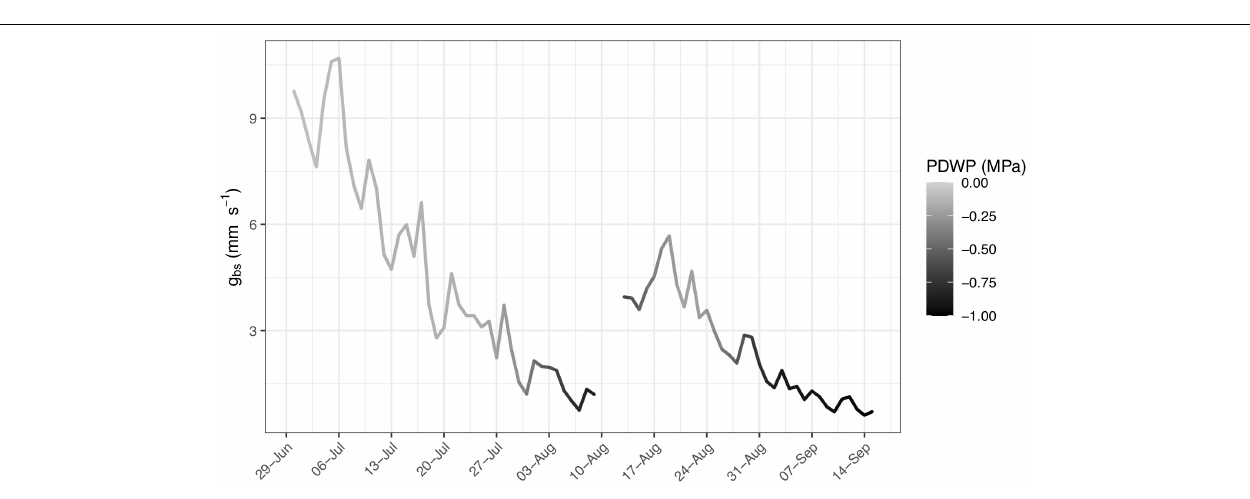
FIGURE 3 | Daily maximum hourly running average of 15-min estimates of the bulk stomatal conductance, g bs (mm s − 1 ) from a selected vine (C5-2) between 30 June and 15 September, 2020 with shading of line representative of corresponding measured predawn leaf water potential varying from 0.0 MPa (light gray) to –1.0 MPa